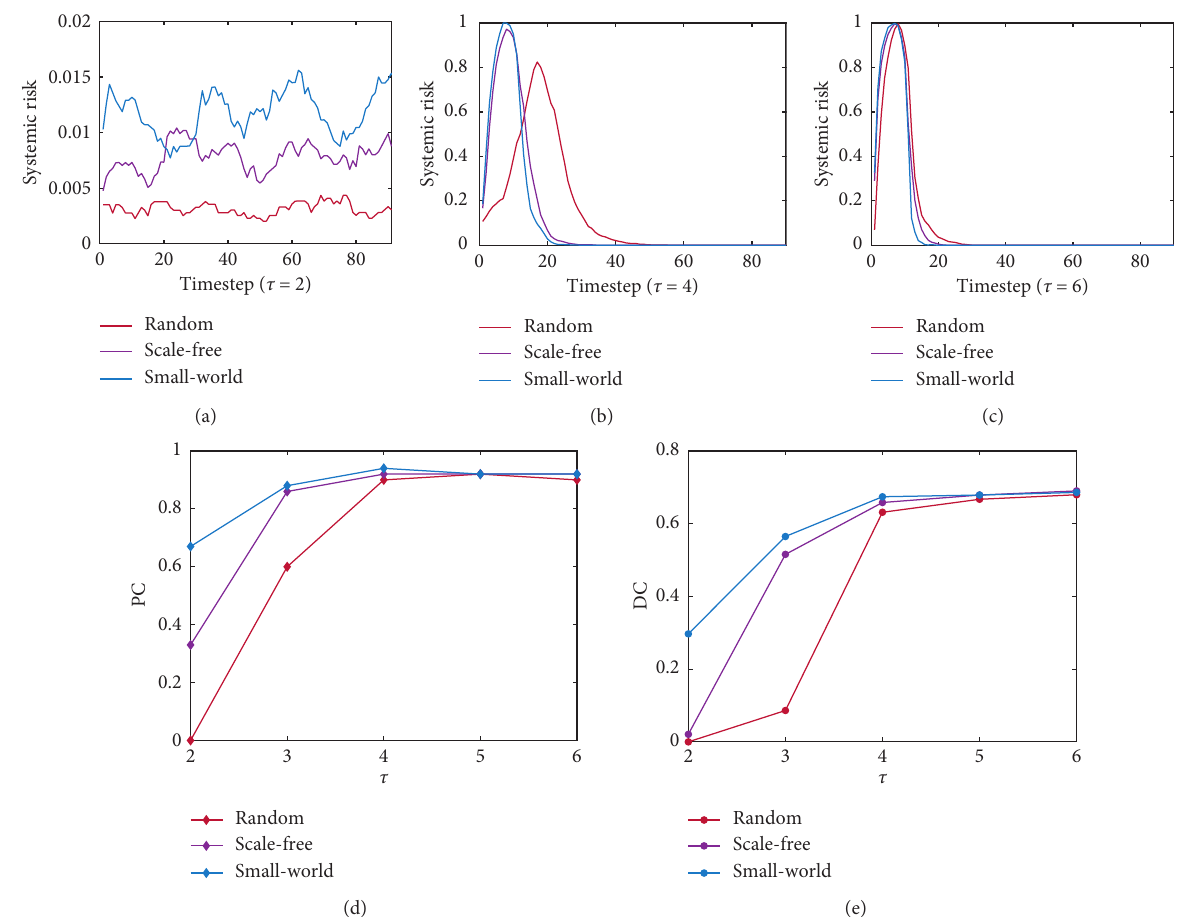
Figure 5: Evolution results of the diverse interbank networks under different τ